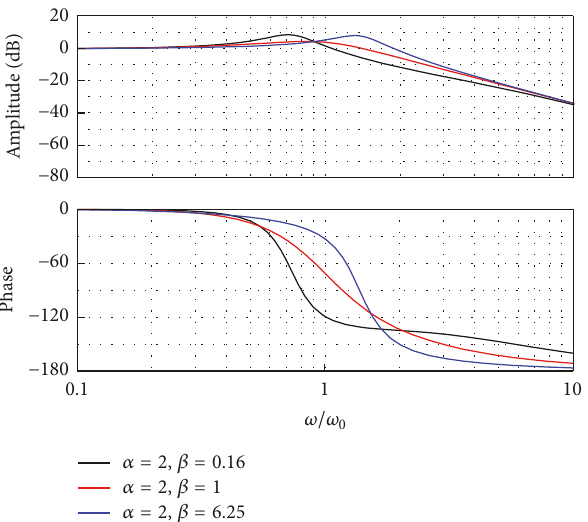
Figure 19: Amplitude-frequency characteristic and phase-fre- quency characteristic ( 𝛼 = 3, 𝛽 = 0.16, 1,6.25